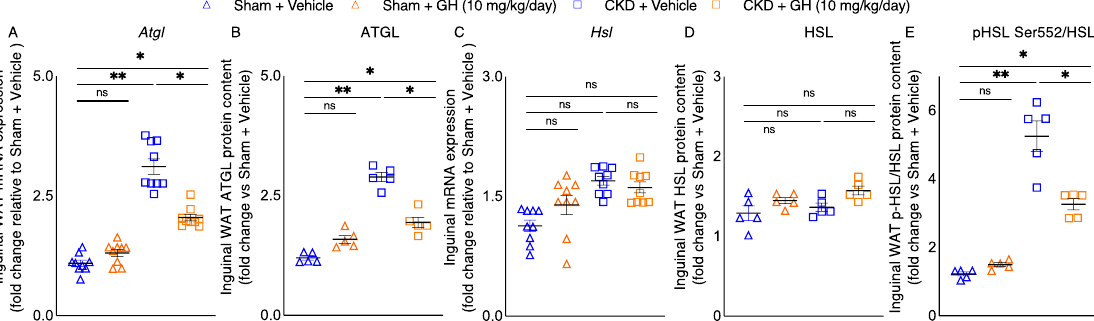
Figure 3. Lipolytic gene expression and protein content in CKD mice. CKD mice were fed ad libitum, Figure 2. GH enhances energy balance in skeletal muscle and adipose tissue. Measurements were whereas other mouse groups received an energy intake amount equal to that of CKD + Vehicle mice. made of the UCP ( A , C , E ) and ATP contents ( B , D , F ) in gastrocnemius, WAT, and BAT. CKD mice By using qPCR, the expression of lipolytic genes (Atgl and Hsl) in the inguinal WAT was deter- were fed ad libitum, whereas other mouse groups received an energy intake amount equal to that of mined ( A , C ). In addition, the total protein content of ATGL and HSL as well as the relative phos- CKD + Vehicle mice. Comparisons were made between the outcomes of Sham + GH (10 mg/kg/day) phorylated HSL/total HSL ratio in the inguinal WAT were evaluated ( B , D , E ). Results are analyzed mice and Sham + Vehicle mice, as well as between the outcomes of CKD + GH (10 mg/kg/day) and expressed as in Figure 2. Data are expressed as mean ± SEM. For comparison of the means mice and CKD + Vehicle mice. Additionally, the outcomes of the CKD + Vehicle and CKD + GH between two groups, data were analyze d by Student’s 2 -tailed t -test. Posthoc analysis was (10 mg/kg/day) mice were contrasted with those of the Sham + Vehicle mice. Data are expressed as mean ± SEM. For comparison of the means between two groups, data were analyzed by Student’s 2-tailed t -test. Posthoc analysis was performed with Tukey’s test. Specific p -values are shown above the bar. ns signifies not significant, * p < 0.05, ** p <